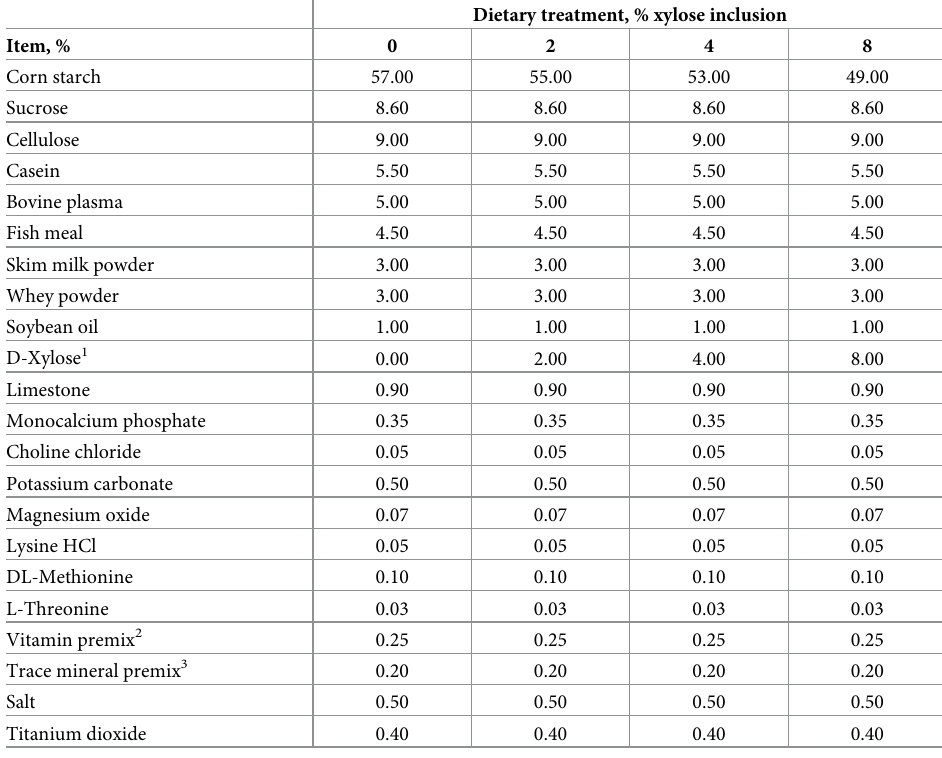
Dietary treatment, % xylose inclusion